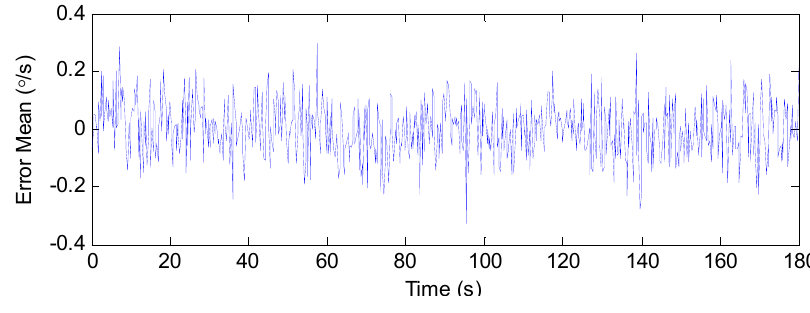
Figure 6. The error mean over different time periods.